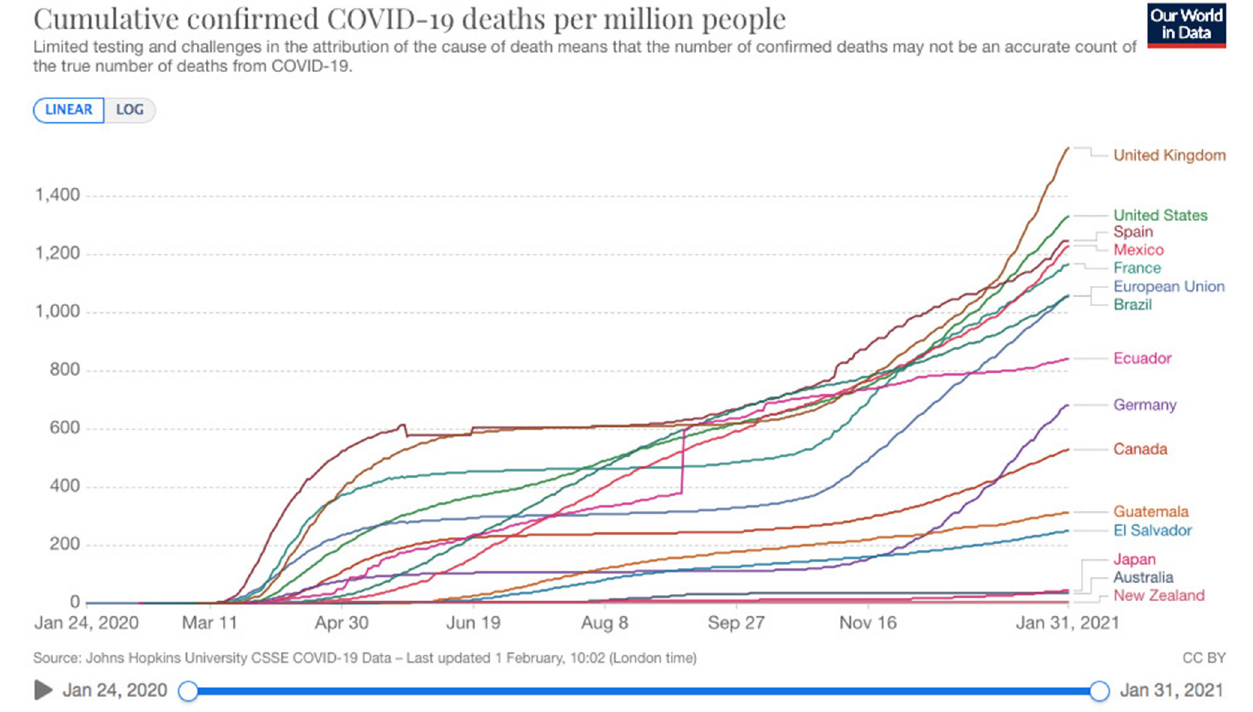
people in loose cultures had far less fear of the Covid-19 virus throughout 2020, even as cases skyrocketed. In tight nations, 70% of people were very scared of catching the virus. In loose cultures, only 49% were. Reality never bit in these populations in part because people in cultures that are adapted to low levels of danger didn’t